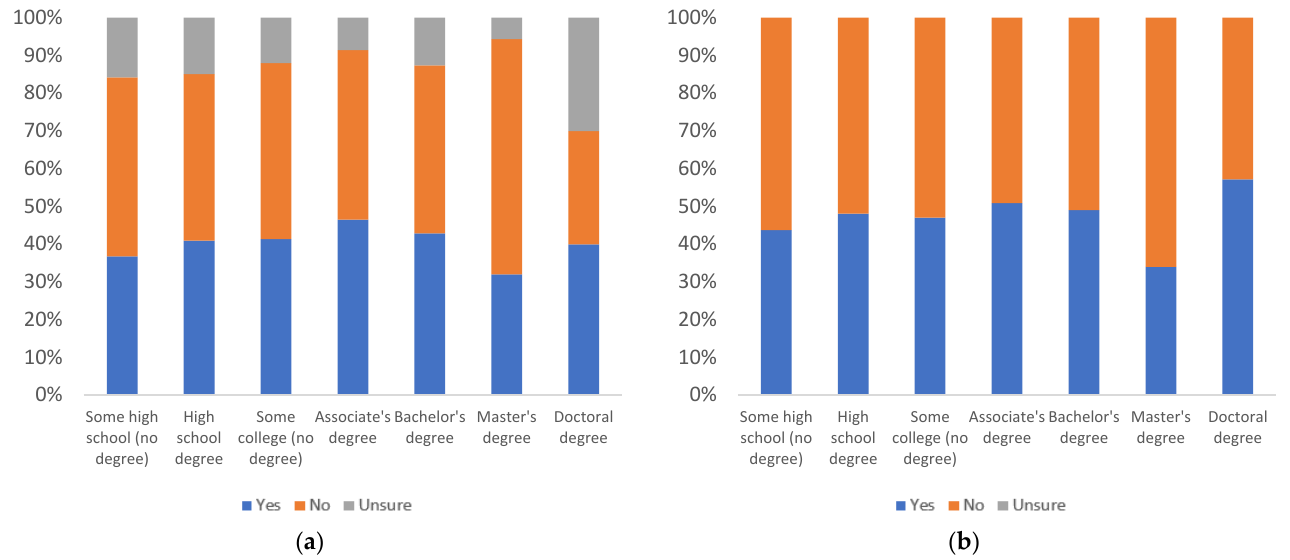
Figure 9. Label annoyingness, by education level: ( a ) with uncertain respondents (left) and ( b ) without uncertain respondents (right).